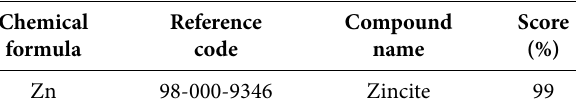
Table 1. Pattern list of ZnO NPs obtained from XRD.